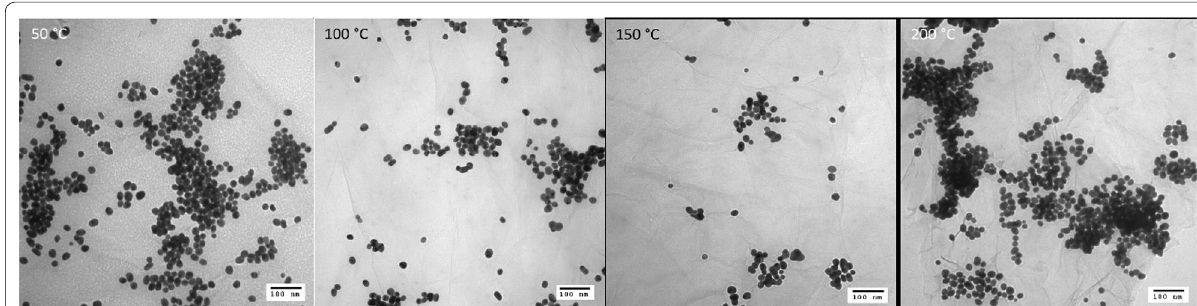
Fig. 5 TEM images (scale bars 100 nm) and size distribution of gAuNP 10nm ‑GO heated at 50, 100, 150, and 200 °C =